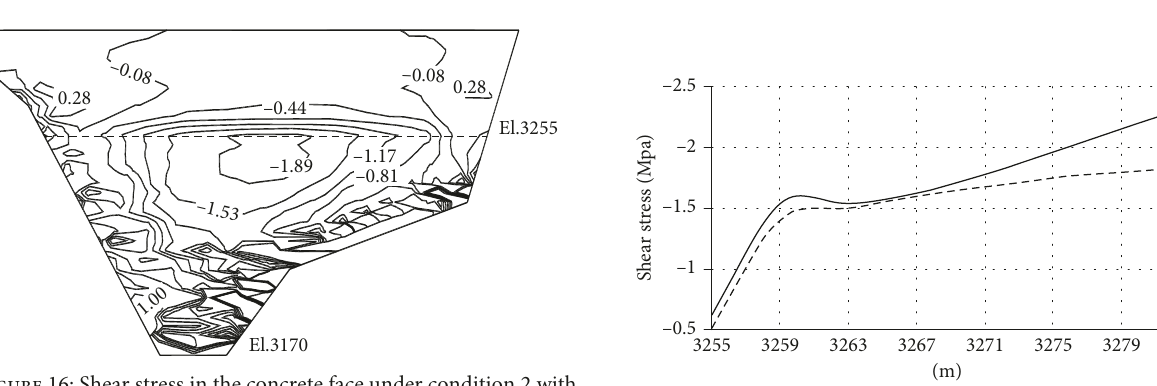
Figure 19: The partial shear stress section of the first stage panel under condition 3 (units: MPa).